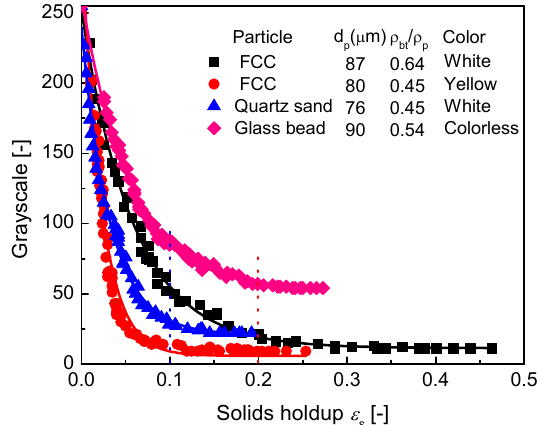
Figure 9. Comparison of calibration curves for Geldart A/A-B particles.